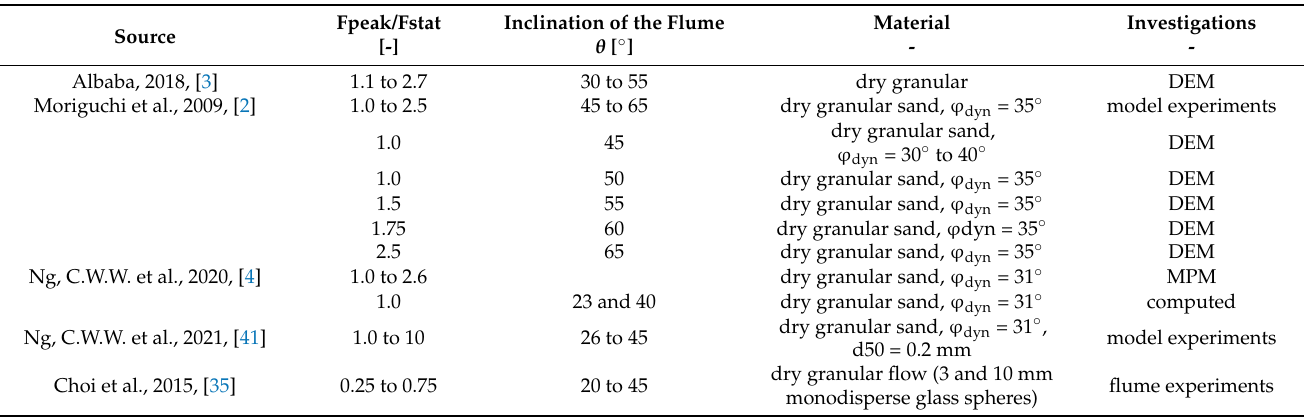
Table 6. Summary of the various literature